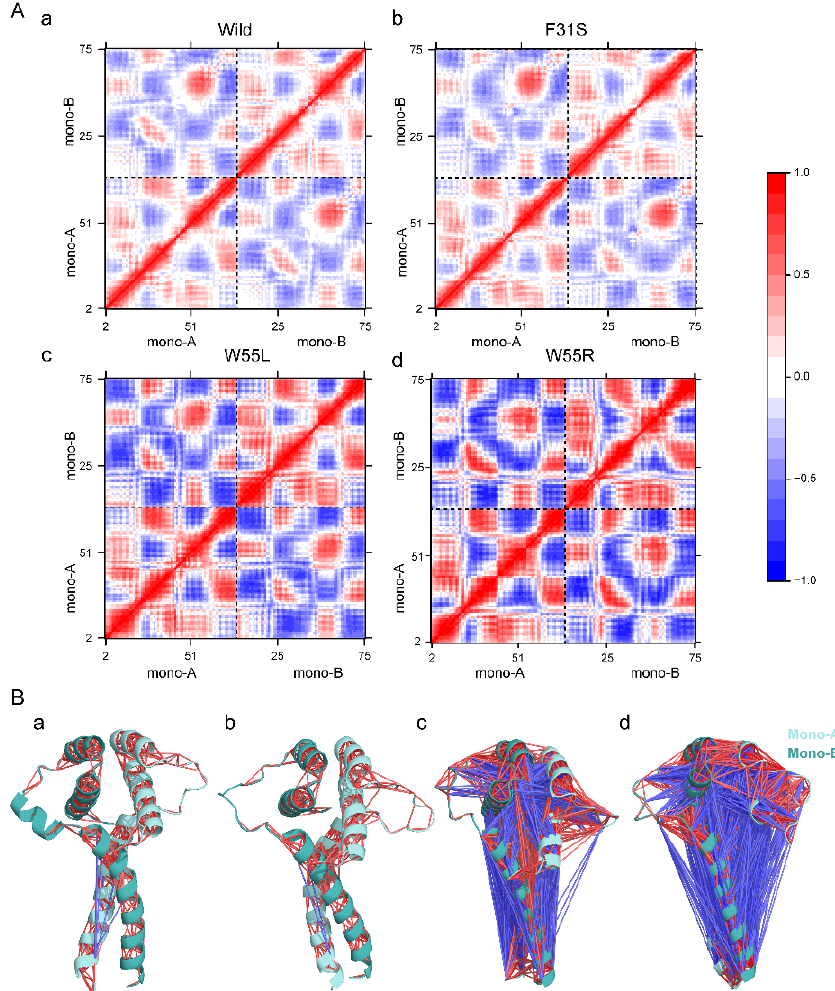
Figure 4. Variants containing LIS1 structures reflect changes in correlated motion. ( A ) The dynamic cross-correlation matrix (DCCM) figure depicts the anticorrelated and correlated movements of each pair of residues in the structure, wild ( a ), F31S ( b ), W55L ( c ), and W55R ( d ). A perfect correlated motion is shown by red (+1), whereas an anticorrelated motion is marked by blue ( − 1). ( B ) DCCM representation in LIS1 structural view, where lines denote the correlation between two residues. wild ( a ), F31S ( b ), W55L ( c ), and W55R ( d ). A blue line was drawn in anticorrelated movements ( − 6 to − 1), while a red line represents a positive correlation (6 to 1). The intensity of the line color reflects the degree of the